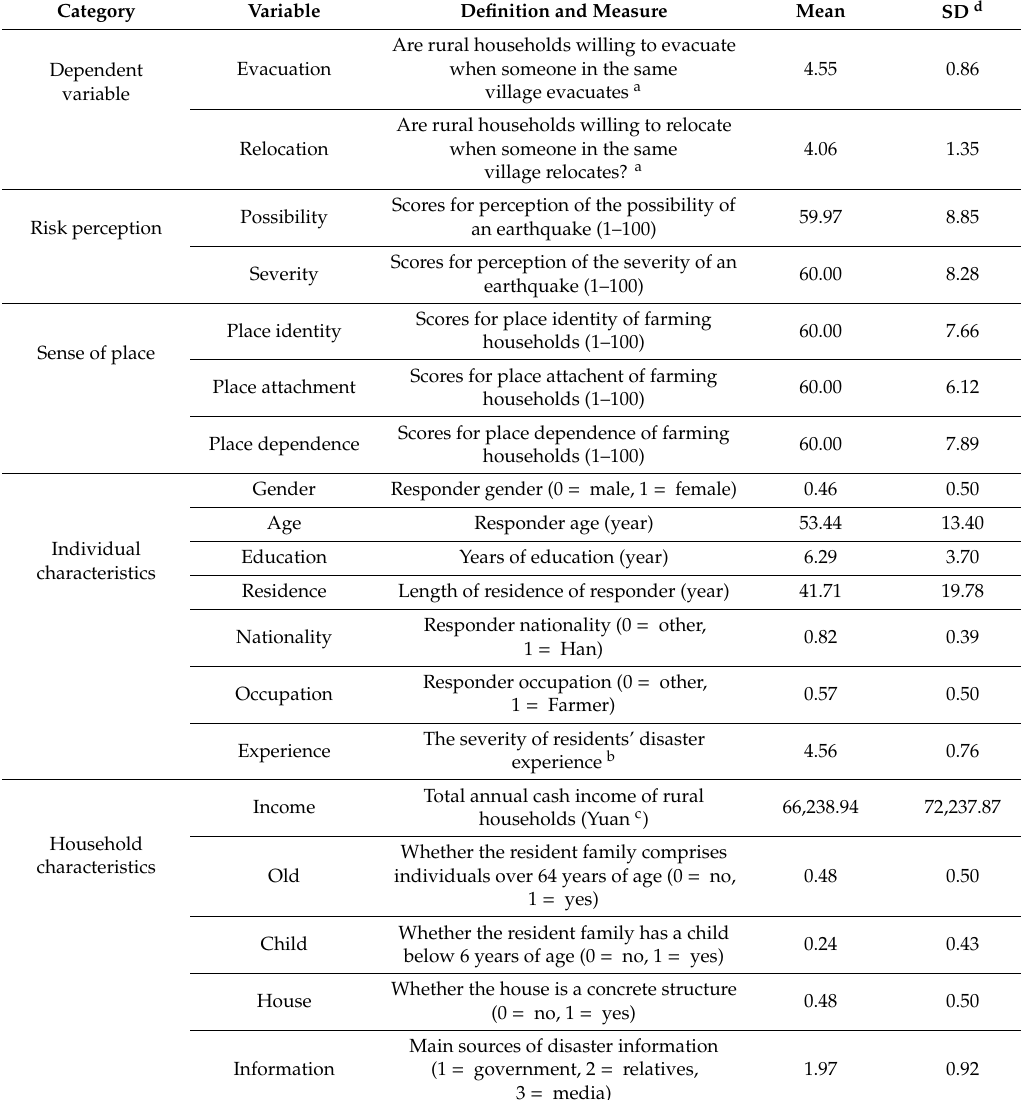
Table 4. Definition and descriptive statistics of the variables in the